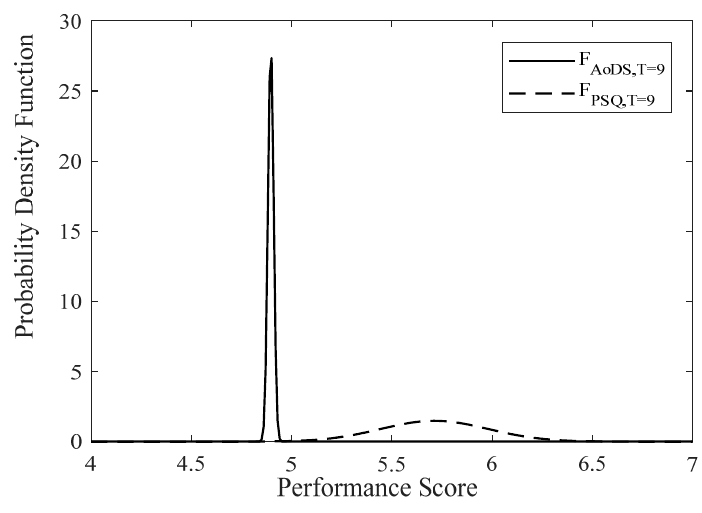
Figure 5. Reliability analysis for PPP schools in Australia case example at t = 9.